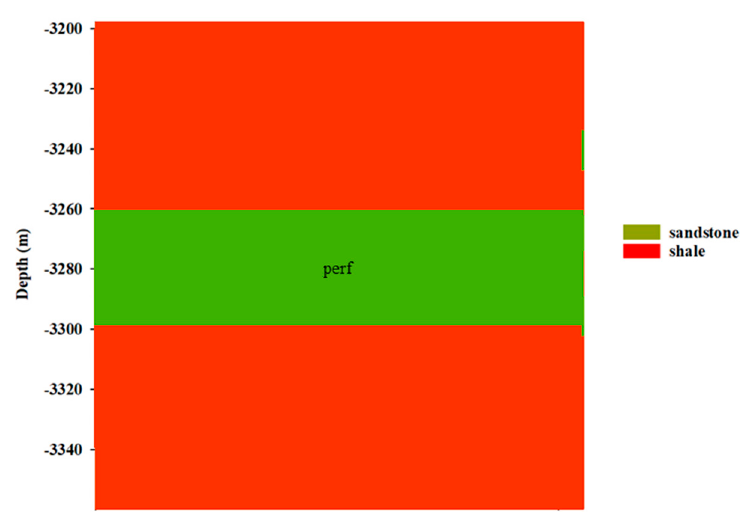
Figure 17. The profile of the formation for the multiple fracture case. Table 7. Pumping schedules of the multiple fracture cases. The stage index refers to the sequence of injected segments.